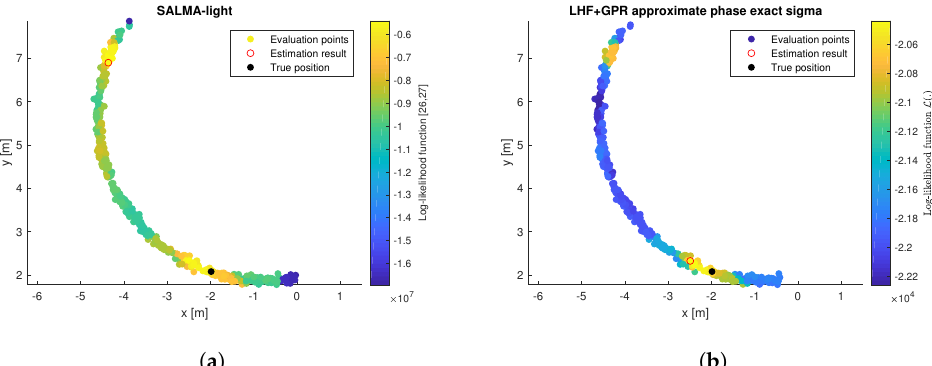
Figure 11. LLHF values obtained using ( a ) SALMA-light, ( b ) LHF+GPR with exact sigma. LLHF values at evaluation points are plotted with color code. The red circle denotes the estimation result, while the filled black circle denotes the true position.